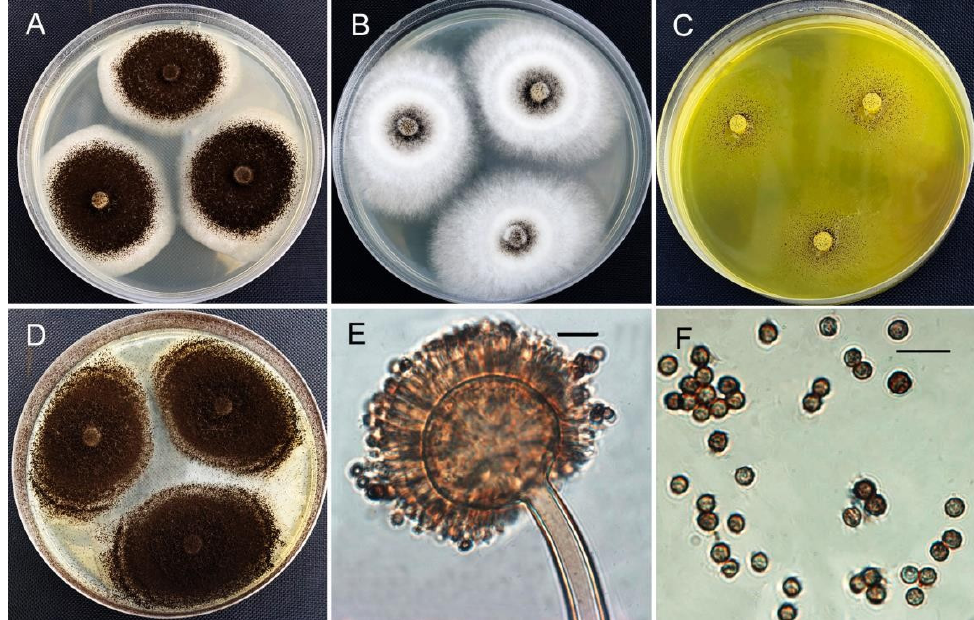
Figure 5. Aspergillus tubingensis isolate HZ123. ( A ) Colonies on CYA after 7 days at 25 °C. ( B ) Colonies on MEA after 7 days at 25 °C. ( C ) Colonies on CREA after 7 days at 25 °C. ( D ) Colonies on CYA after 7 days at 37 °C. ( E ) Conidiophores. ( F ) Conidia. Scale bars = 10 μ m.